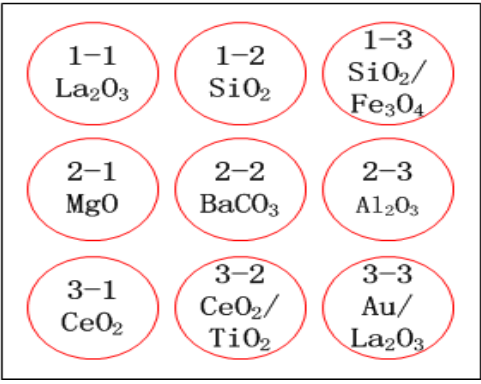
Figure 2. Arrangement of material spots on the sensor array.